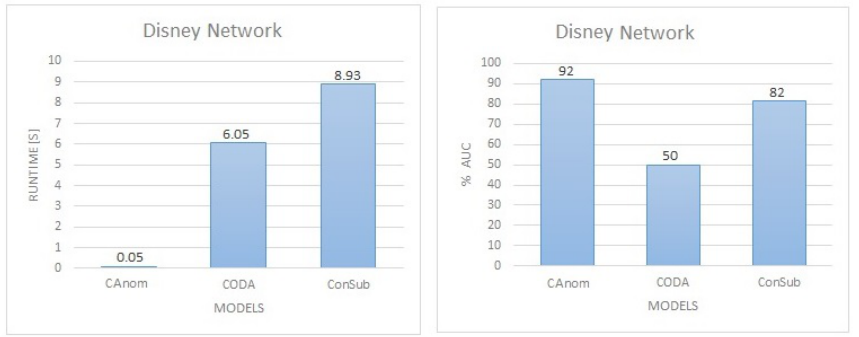
Figure 3. Quality and runtime evaluation for the Disney network.